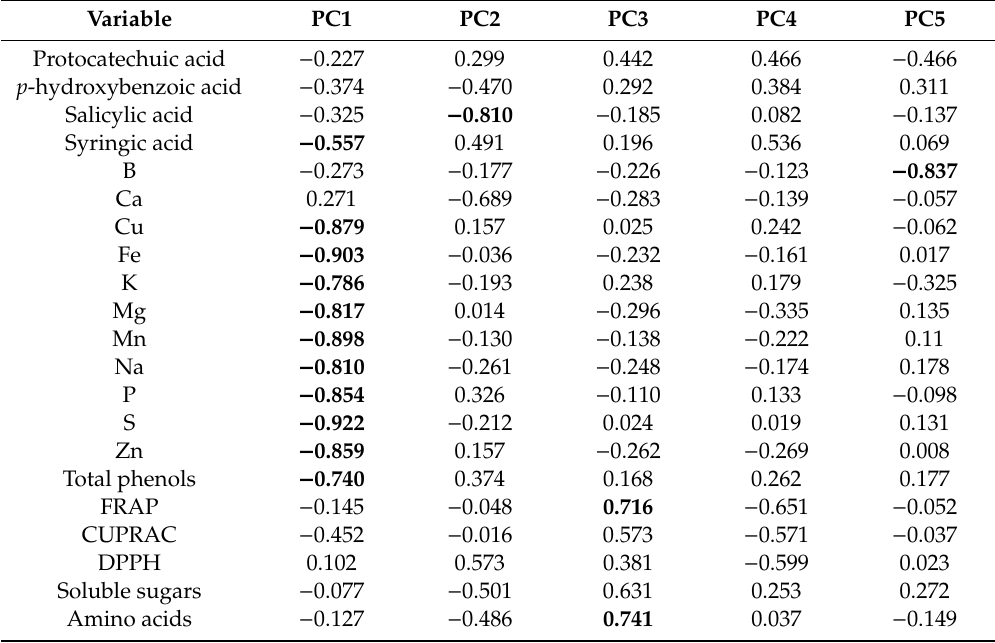
Table 6. Factor loadings of analyzed variables for the first five principal